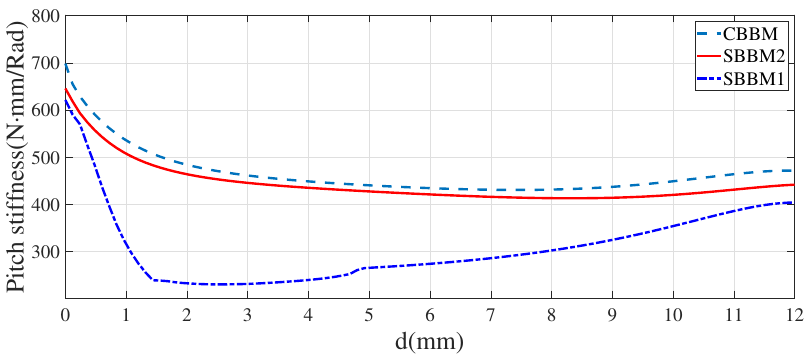
Figure 12. Pitch stiffness of CBBM and SBBMs 1 and 2 at different shuttle